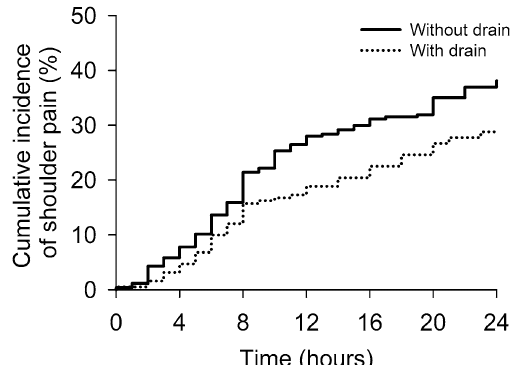
Figure 1. Cumulative incidence of shoulder pain of the groups with drain and without